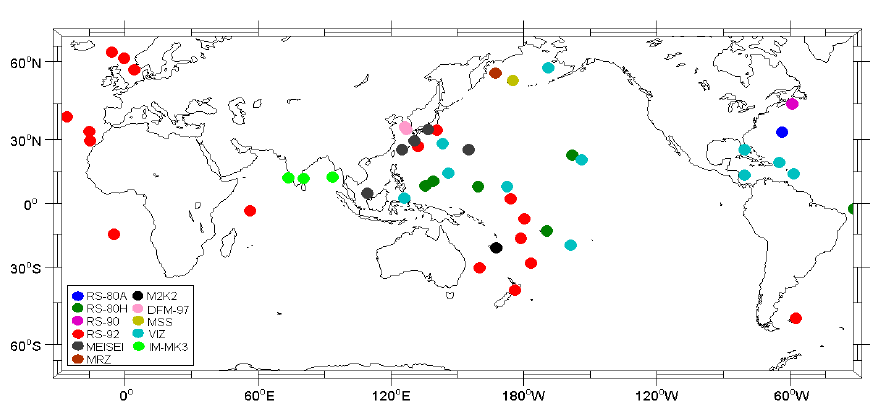
Figure 1. Geographic distribution of matched radiosonde stations. Di ff erent colors indicate the 11 sounding types used in the